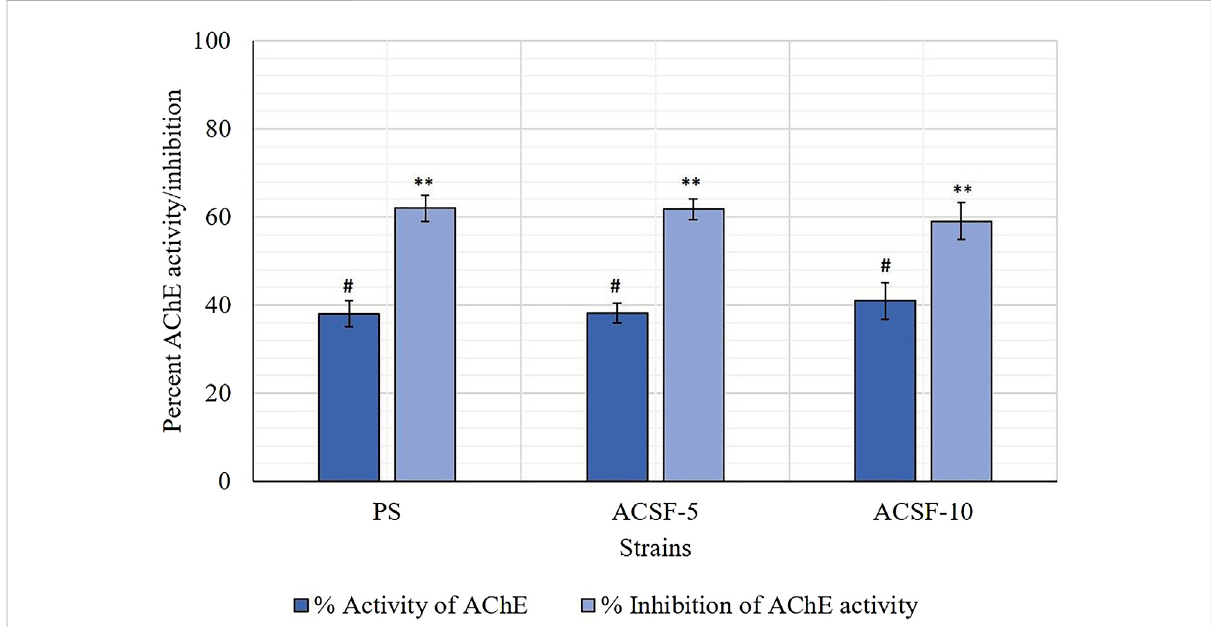
FIGURE 6 Comparative percent inhibition of the AChE activity in PS (parent susceptible), ACSF-5 (acetamiprid larval-selected fi lial-5), and ACSF-10 (acetamiprid larval-selected fi lial-10) strains of Aedes aegypti ( n = 100). The AChE inhibition/activity indicated by the same letter on bars are not signi fi cantly different ( p < 0.05); computed by one-way ANOVA followed by Tukey ’ s all pairwise multiple comparison